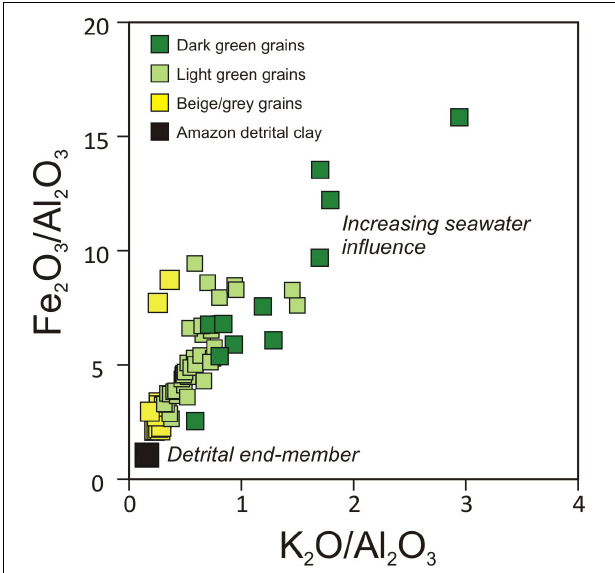
FIGURE 6 | Relationship between Fe 2 O 3 /Al 2 O 3 and K 2 O/Al 2 O 3 in glauconitic grains of core IG-KSF-11, based on SEM/EDS microanalyses. Values for Amazon detrital clay are from Bayon et al. (2015).